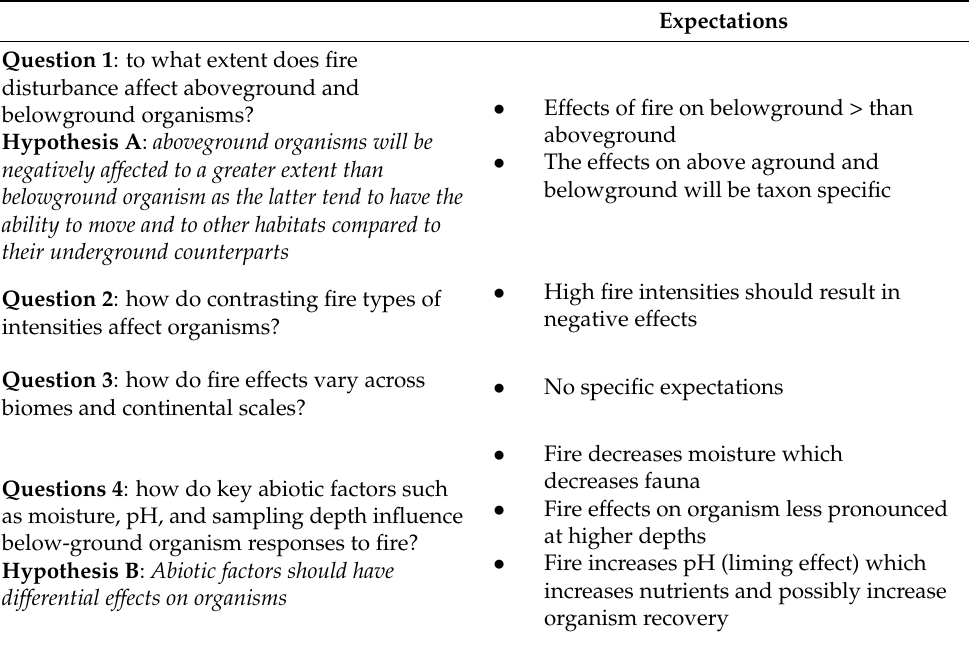
Table 1. Tabular summary of the study questions, hypotheses, and expectations. See methods (Section 2.3) for statistical descriptions used to address questions in this